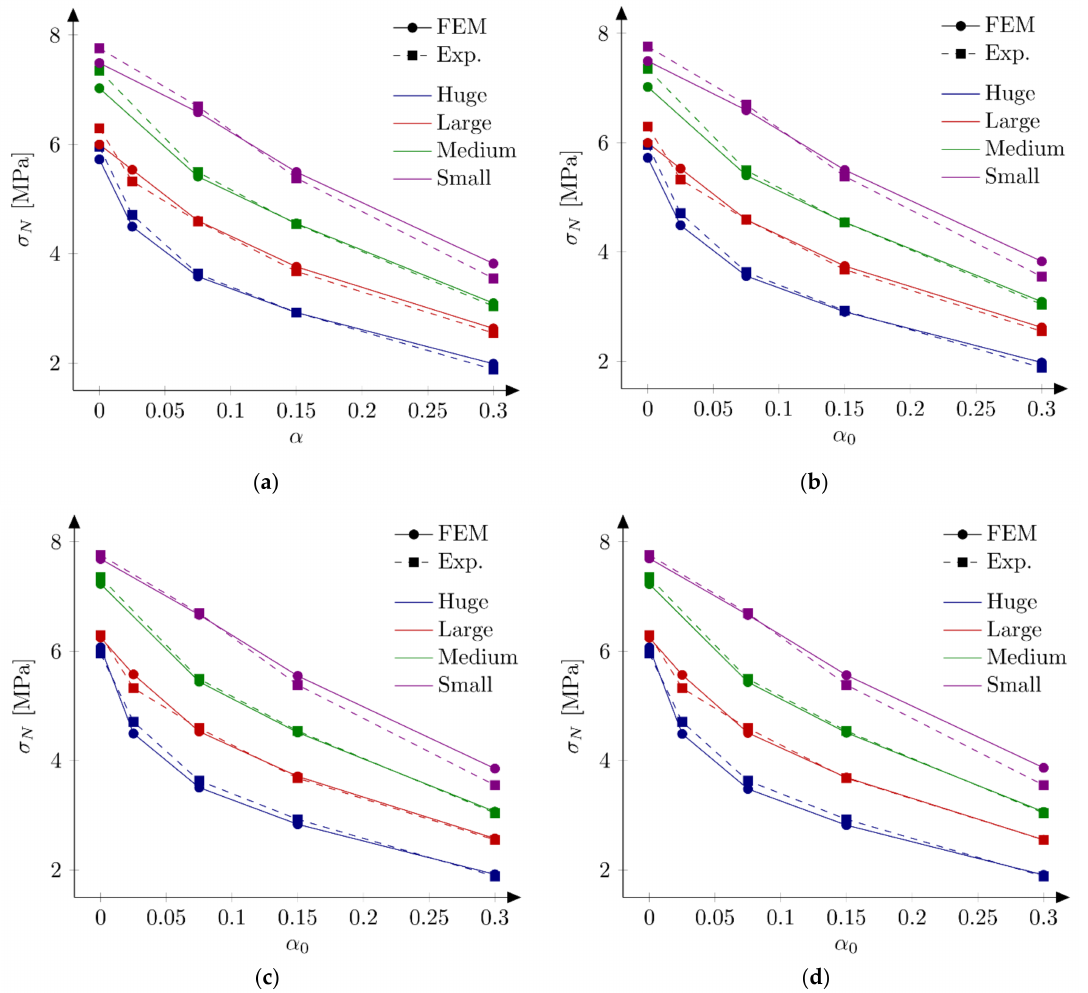
Figure 9. Nominal and experimental strengths with bilinear softening law and: ( a ) set S5: f t = 4.8 MPa, G f = 48 N/m, b = 0.5 cm, β 0 = 0.7; ( b ) set S6: f t = 4.8 MPa, G f = 48 N/m, b = 1.0 cm, β 0 = 0.8; ( c ) set S7: f t = 5.2 MPa, G f = 42 N/m, b = 0.5 cm, β 0 = 0.7; ( d ) set S8: f t = 5.2 MPa, G f = 42 N/m, b = 1.0 cm, β 0 =